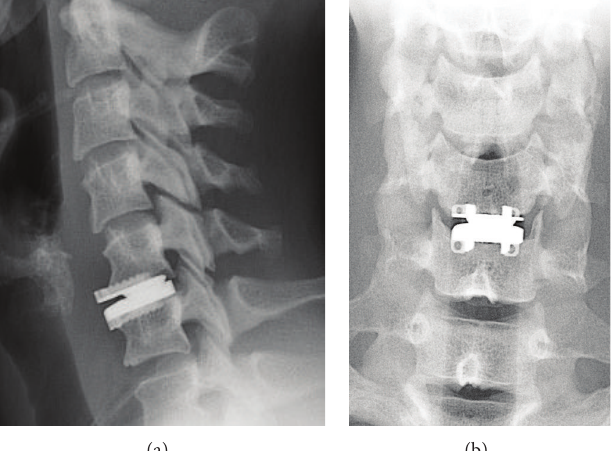
Figure 1: Postoperative lateral (a) and AP (b) radiographs demonstrating that the implant is well positioned on the AP (anteroposterior) view and slightly prominent on the lateral view.